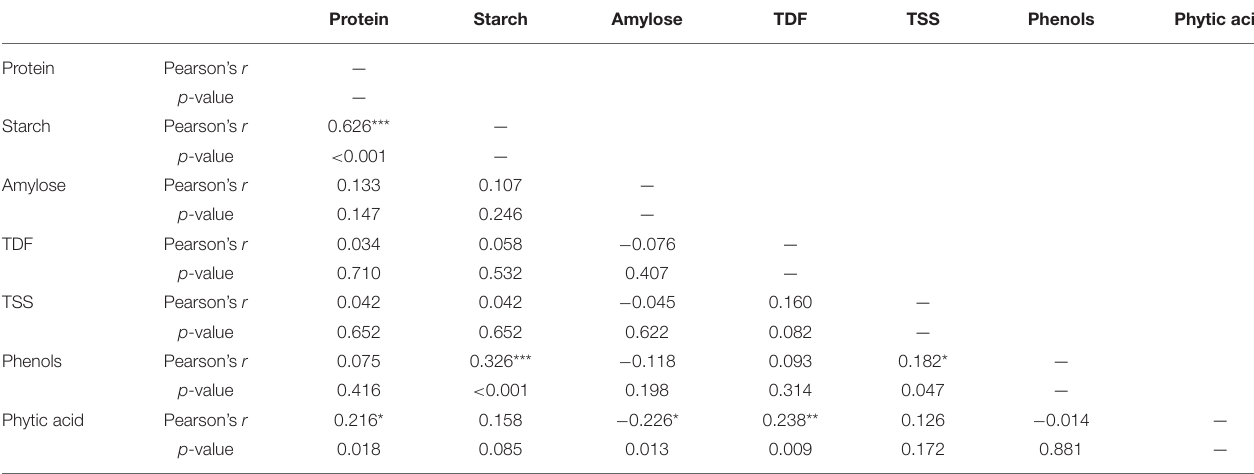
TABLE 2 | Correlation matrix for seven biochemical traits of 120 cowpea accessions. Protein Starch Amylose TDF TSS Phenols Phytic